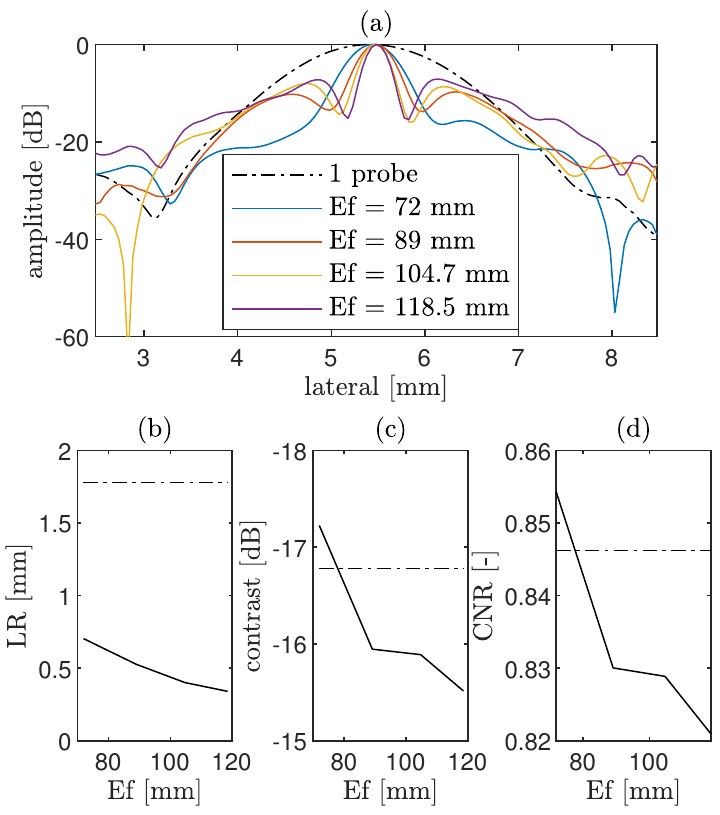
Figure 6. ( a ) Lateral point-spread-function (PSF) extracted from Figure 5 at the depth of peak point intensity and in the principal direction. Corresponding computed quality metrics as a function of the effective aperture size in CoMTUS (solid line) compared with the one probe system (dashed line): ( b ) lateral resolution (LR); ( c ) contrast; and ( d ) contrast-to-noise-ratio